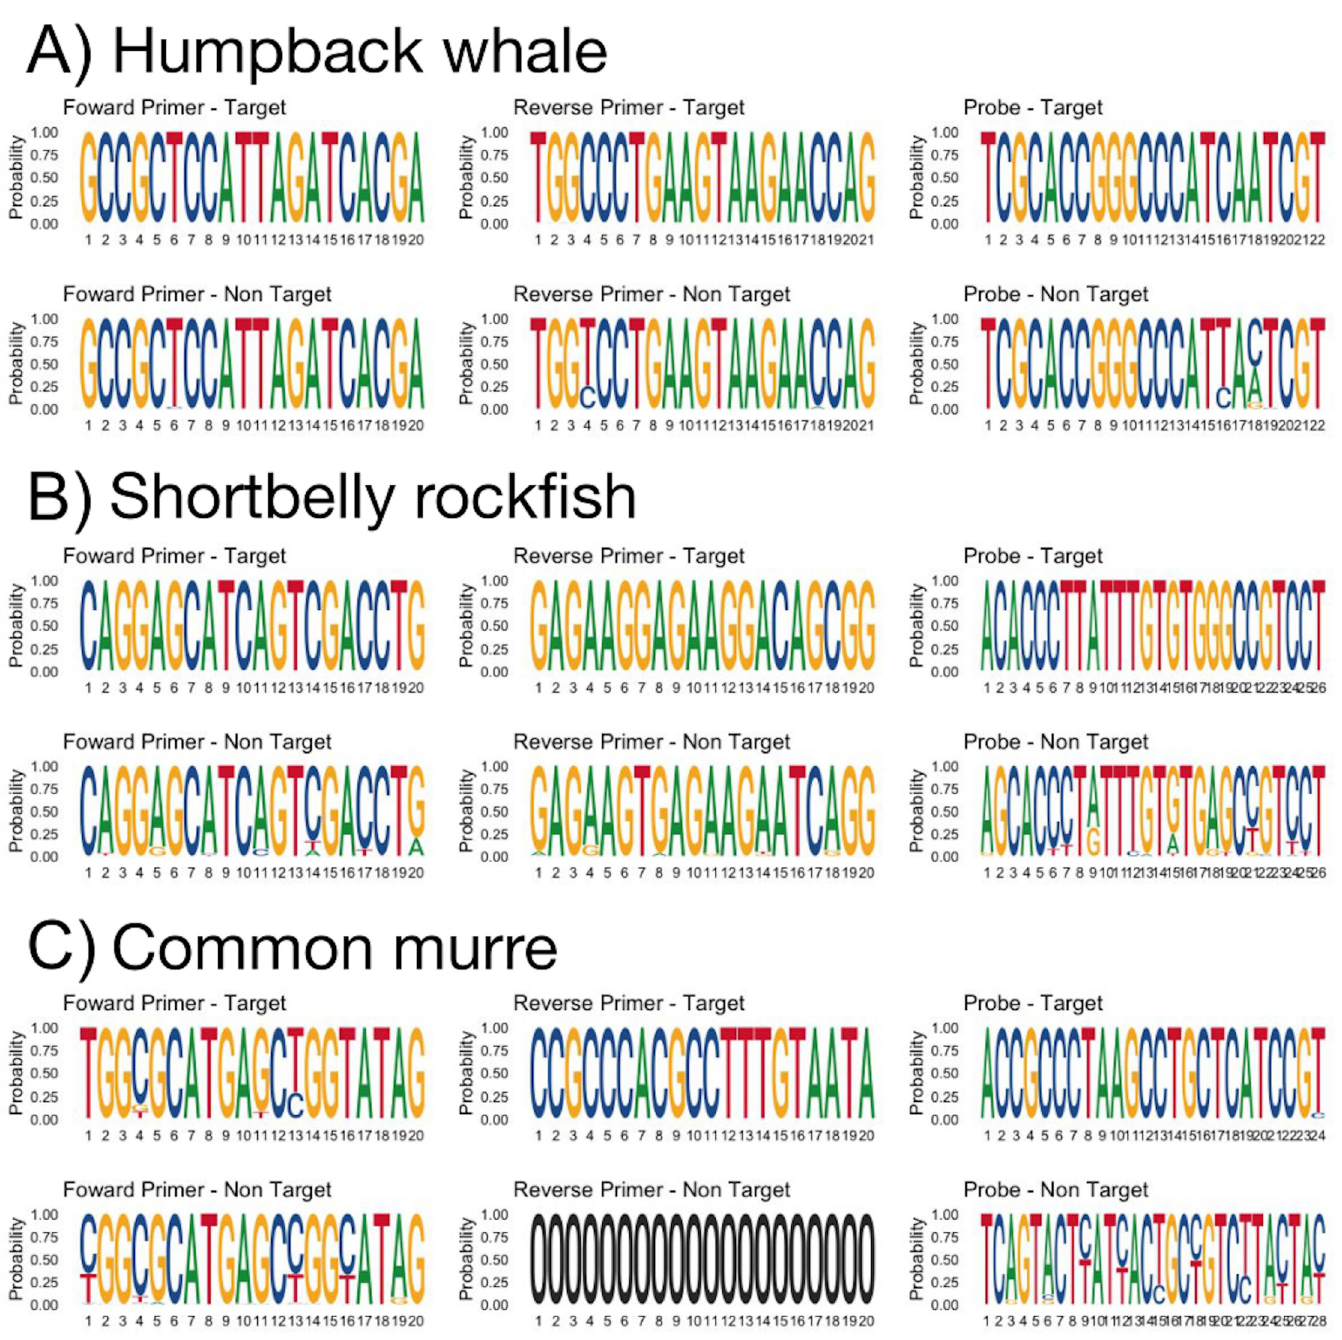
Fig 1. Sequence logo plots of in silico sensitivity and specificity of primers and probes for each qPCR assay. Panel A shows humpback whale, Panel B shows shortbelly rockfish, and Panel C shows common murre. For each panel, the top plots are generated by aligning the regions of the forward primer, reverse primer, and probe, respectively, of target species for each assay and the bottom plots are generated by aligning the same regions for non-target species. The x-axis is the order of base pairs in the primer or probe and the y-axis is the relative frequency of base pair occurrence, with the size of each letter corresponding to its relative frequency. Letters are stacked if multiple base pairs occur at that position in the primer or probe and relative frequencies always sum to 1. The reverse primer for common murre shows as “0” for all base pairs because no contigs were found when non-target species (within the family Alcidae) were aligned with the reverse primer sequence. All sequences are shown from 5’ to